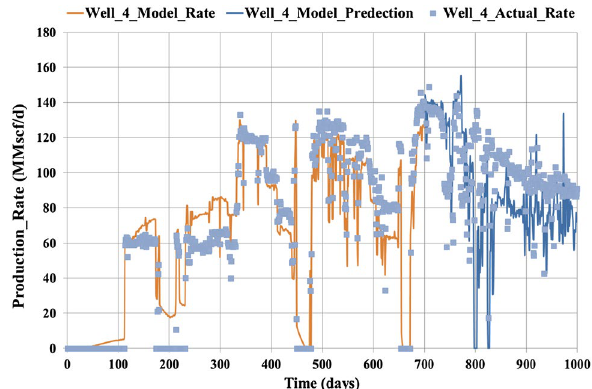
Fig. 7 Well 4 rate history match and prediction (case 1)